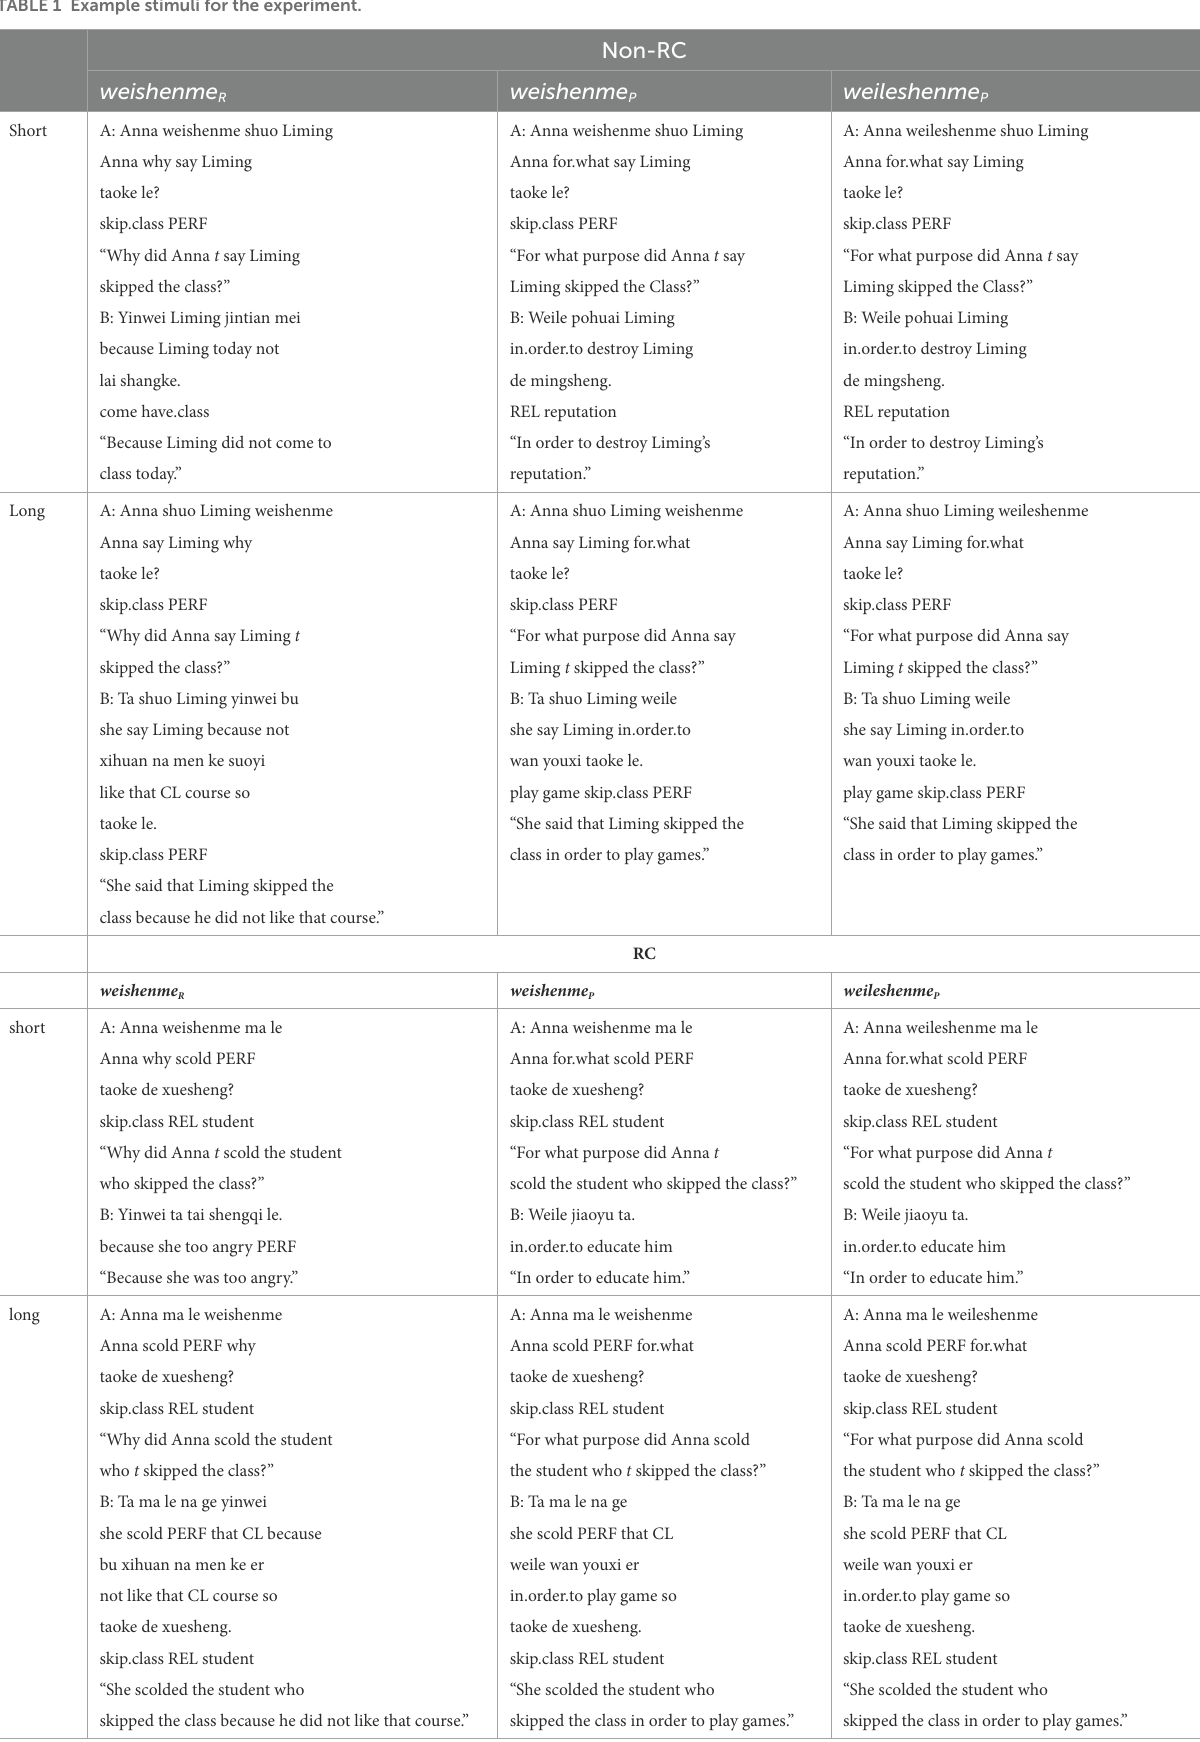
TABLE 1 Example stimuli for the